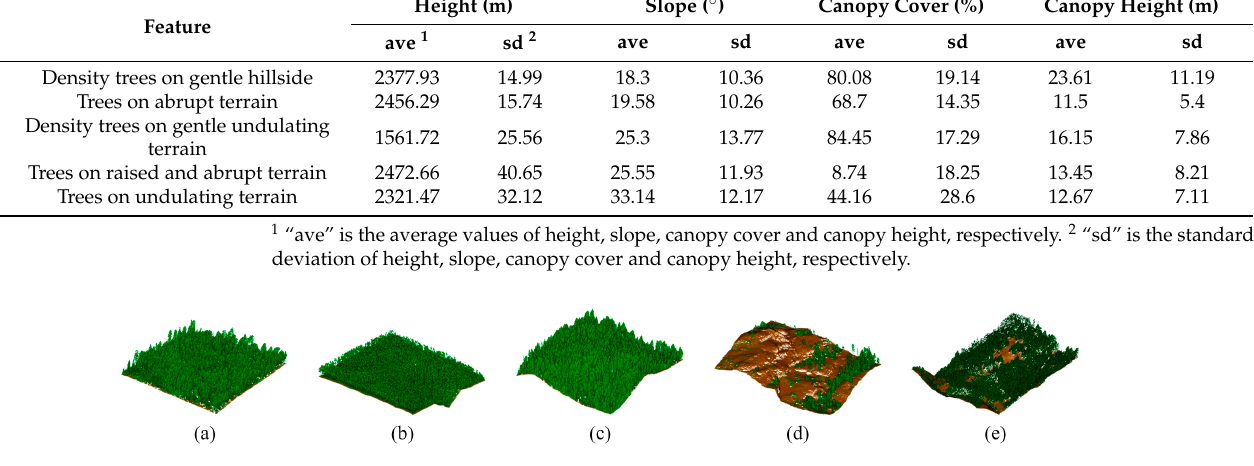
Figure 7. LiDAR point clouds of five forested sites: ( a ) Site 1, ( b ) Site 2, ( c ) Site 3, ( d ) Site 4 and ( e ) Site 5. Ground and non-ground points were colored brown and green, respectively.